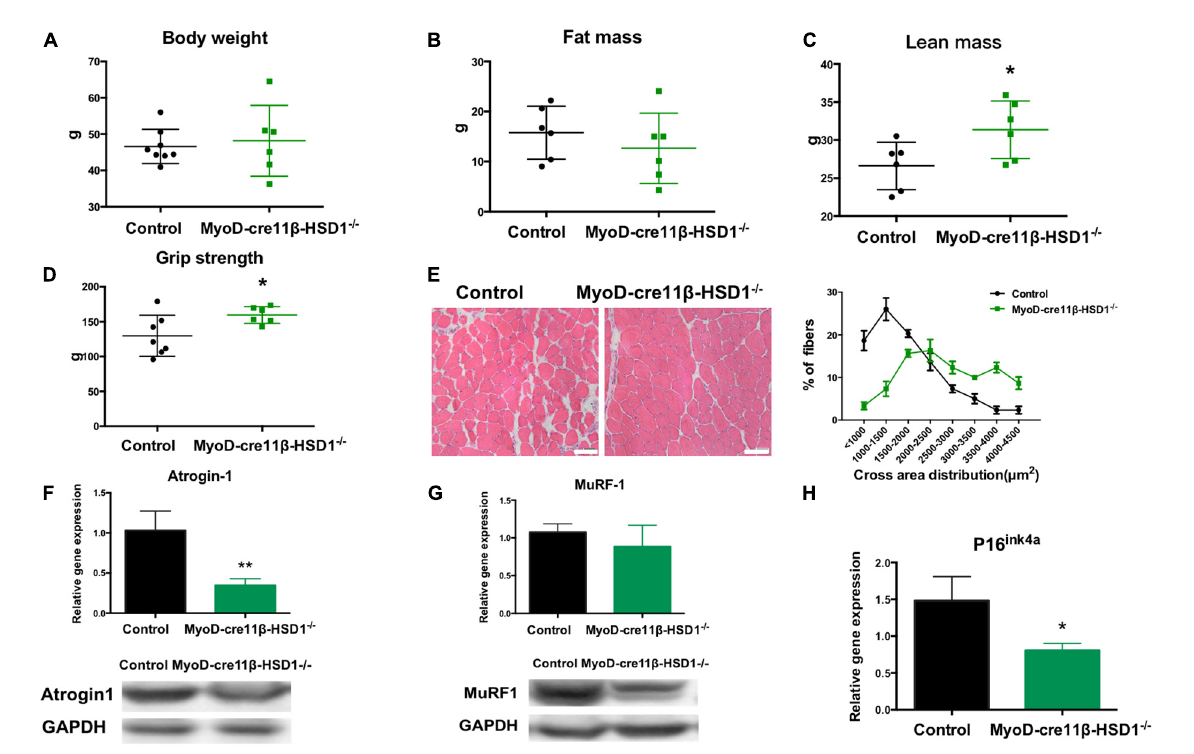
FIGURE4 Muscle-specific 11 β -HSD1 knockout rescued age-related muscle atrophy in aged mice. (A) Body weight of MyoD-cre 11 β -HSD1 KO mice ( n = 6) and control mice ( n = 8) at 22 months of age. (B) Muscle strength of MyoD-cre 11 β -HSD1 KO mice ( n = 6) and control mice ( n = 6). (C) Lean mass of MyoD-cre 11 β -HSD1 KO mice ( n = 6) and control mice ( n = 6). (D) Fat mass of MyoD-cre 11 β -HSD1 KO mice ( n = 6) and control mice ( n = 7). (E) Representative HE staining images of muscle cross sections derived from muscle-specific 11 β -HSD1 knockout mice and control mice. Scale bars, 50 µ m. Percentage distribution of muscle fiber cross-sectional area derived from muscles. (F,G) mRNA and protein levels of the muscle atrophy factors atrogin-1 and MuRF-1 in muscles ( n = 6 mice per group). (H) mRNA quantification of the senescence marker gene p16 ink4a in muscles ( n = 6 mice per group). * p < 0.05, ** p <